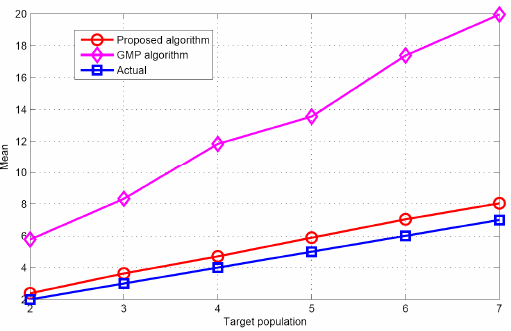
Figure 5. The mean of the estimated populations versus target population.